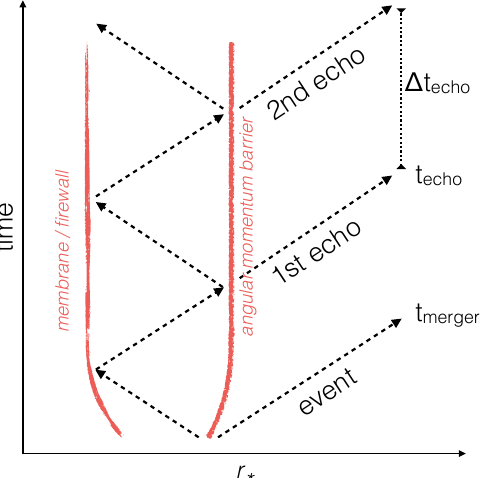
Figure 9. GW echoes following a BBH merger from a cavity of membrane/firewall-angular momentum barrier